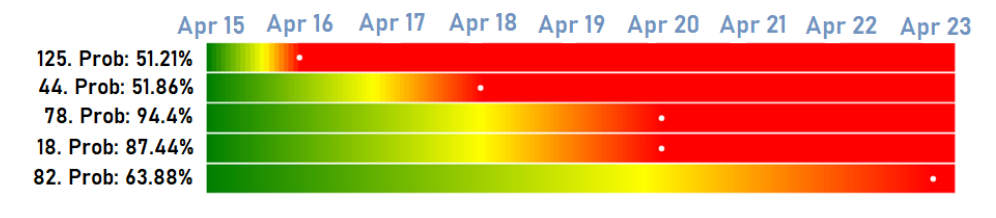
Figure 3. Example of system output for five failure modes (named 125, 44, 78, 18 and 82) sorted temporally. Each row depicts the evolution of the probability of failure along the time. The points where the failure probability reaches its peak are marked with white